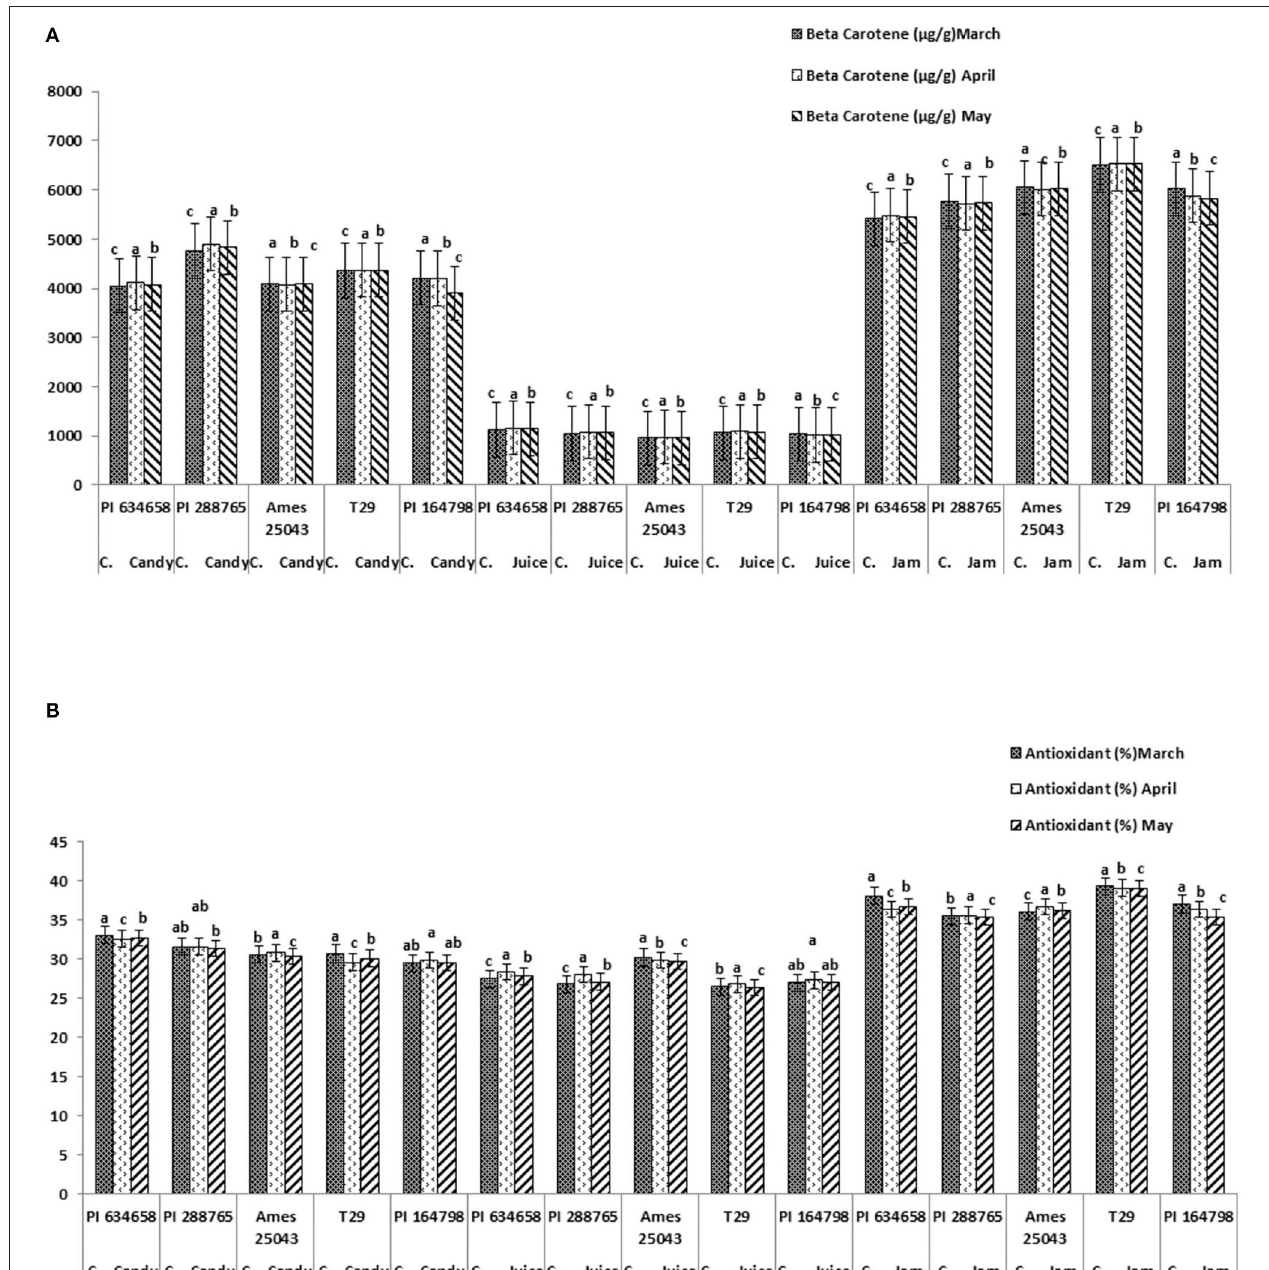
FIGURE 8 | (A) β -carotene content ( µ g/100g) of three nutraceutical products from five carrot genotypes stored 3 months. (B) Antioxidant activity (%) of three products from five carrot genotypes stored 3 months.